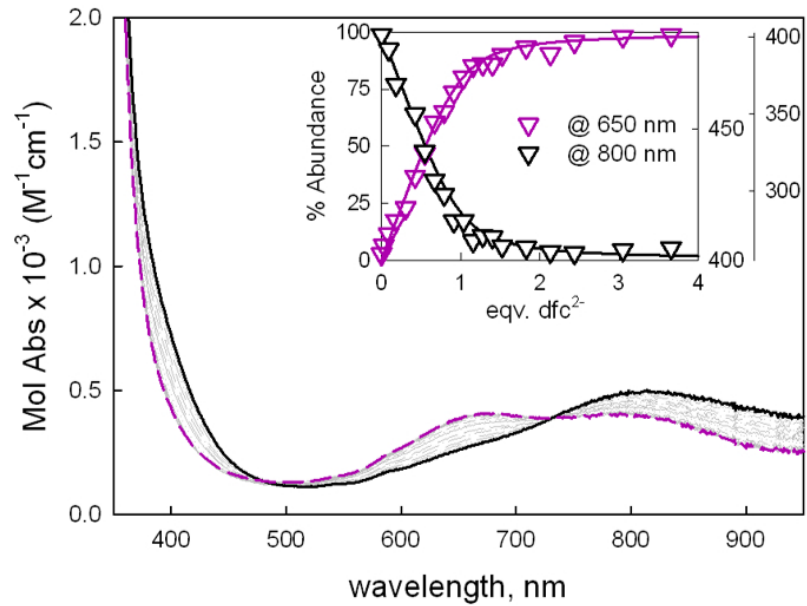
Figure 2. UV-Vis spectra taken upon titration of [Cu 2 L](CF 3 SO 3 ) 4 (50 µ M) with dfc 2 − (as the TBA salt) in H 2 O:CH 3 CN 1:4 at pH 7 (0.02M HEPES buffer; path length = 10 cm). The inset shows the titration profiles at 650 and 800 nm, with the superimposed distribution diagrams of the dicopper complex (C) containing species: purple line, [Cu 2 L(dfc)] 2+ ; black line, [Cu 2 L] 4+ ; LogK 11 = 5.46(2). Table 1. Binding constants obtained by UV-Vis and fluorimetric (indicator displacement, ID) titrations. % I/I max = % recovery of the emission intensity at 570 nm (taken at 8 eqv. of the added anion). Details are reported in the text and in SI. n.a.: not available. LogK